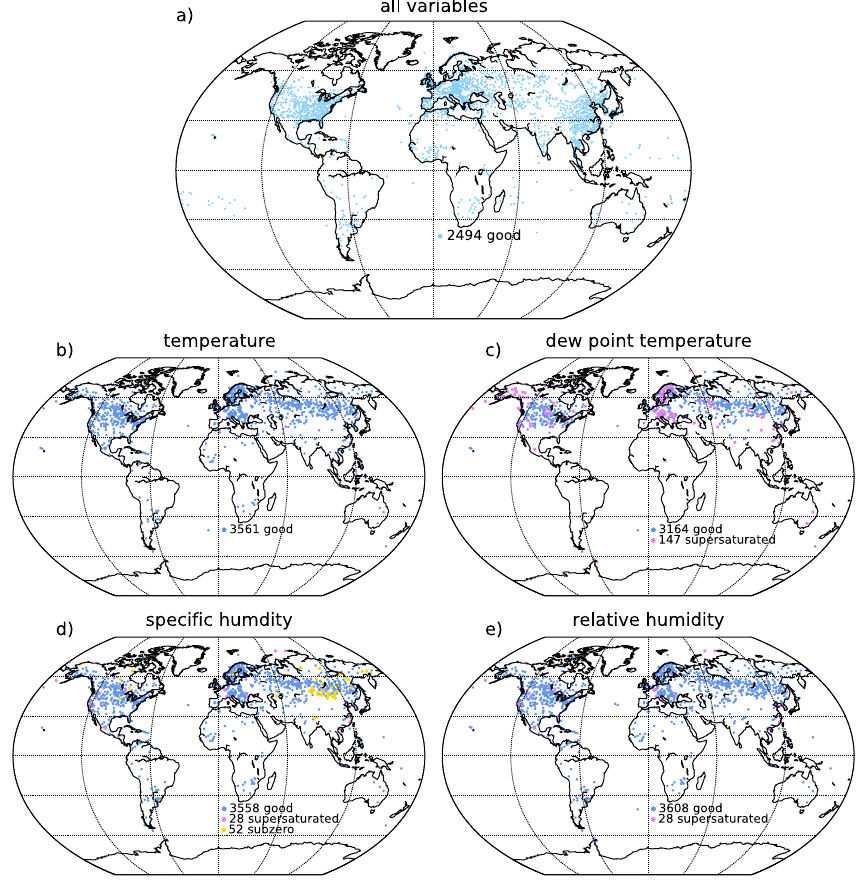
Figure 2. Final station coverage maps with supersaturated and subzero error stations identified that are not included in the final HadISDH data sets. (a) Good stations common to all variables, (b) additional temperature stations, (c) additional dew point temperature stations, (d) additional specific humidity stations, and (e) additional relative humidity stations. See Fig. SM1 for other